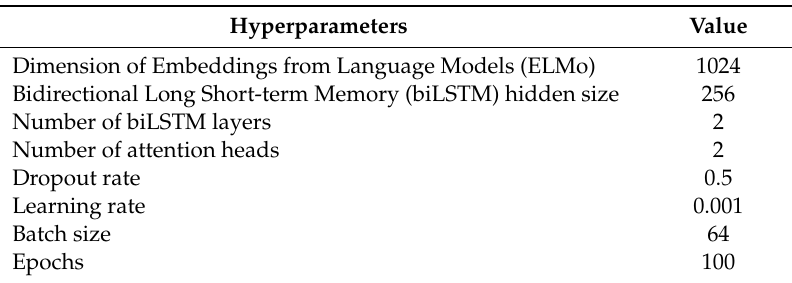
Table 2. Hyperparameters chosen in our